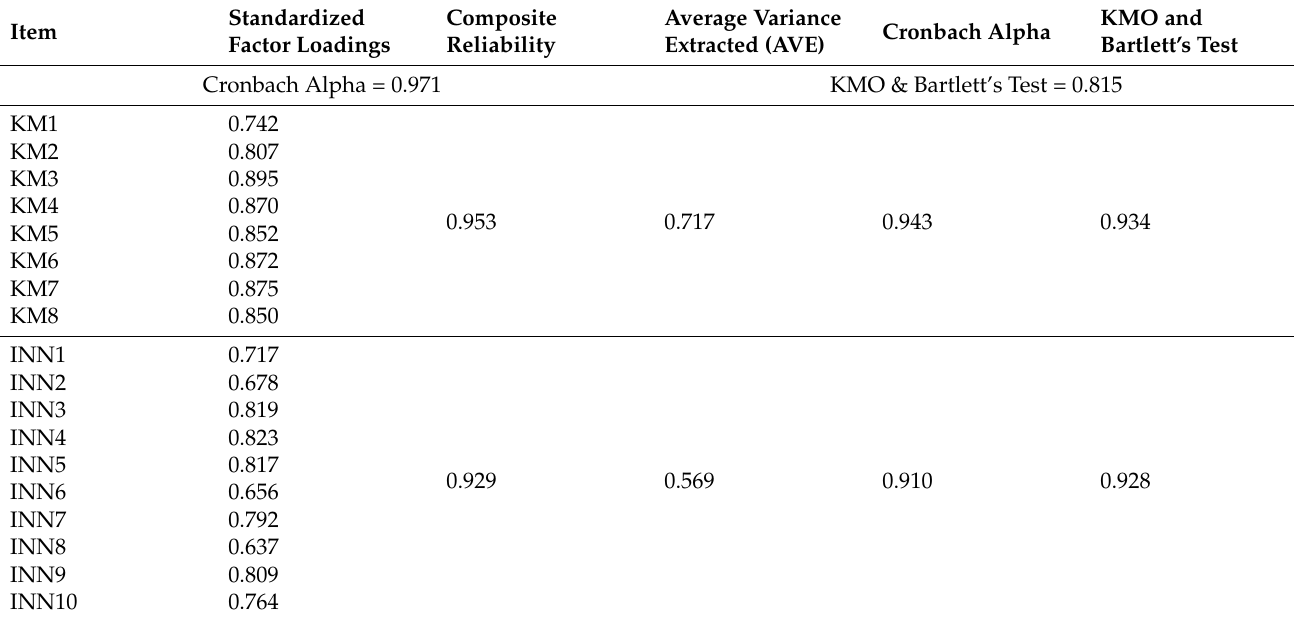
Table 2. Construct reliability and validity Using CR, AVE, Cronbach’s’ Alpha, and KMO